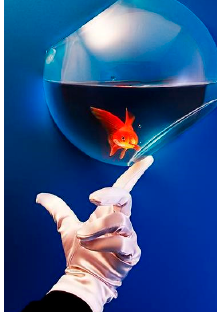
Figure 9. Original image.